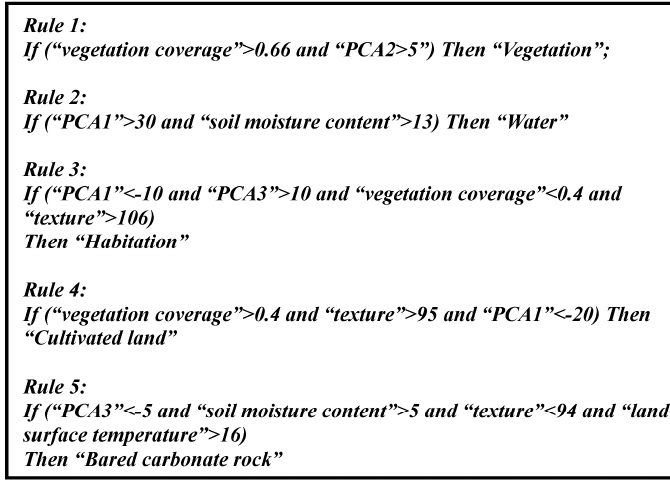
Figure 7. The final rules after verification and post-processing.